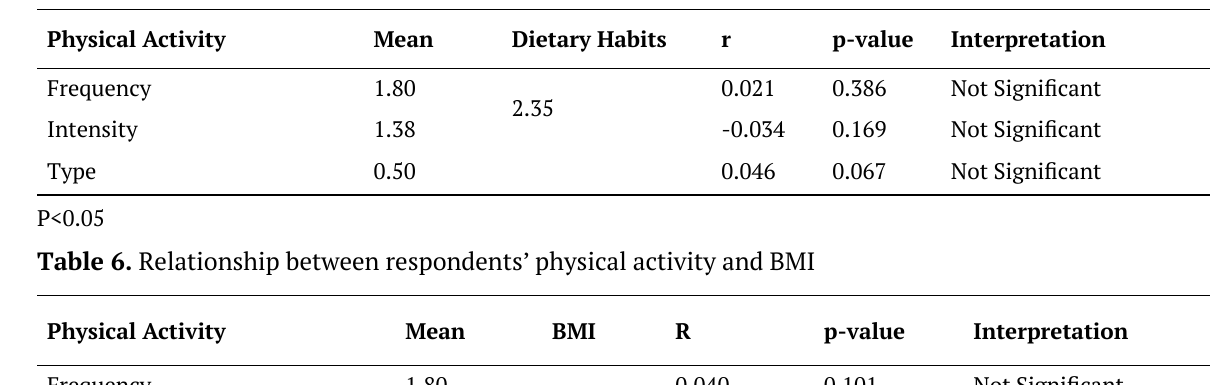
Table 5. Relationship between respondents’ physical activity and dietary habits